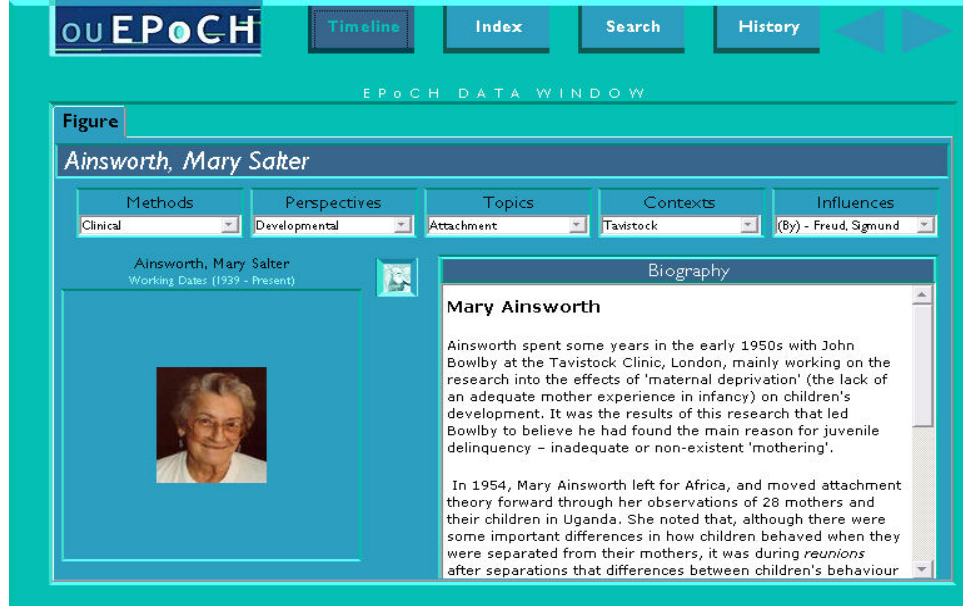
Figure 10 . A sample snapshot from the original EPoCH